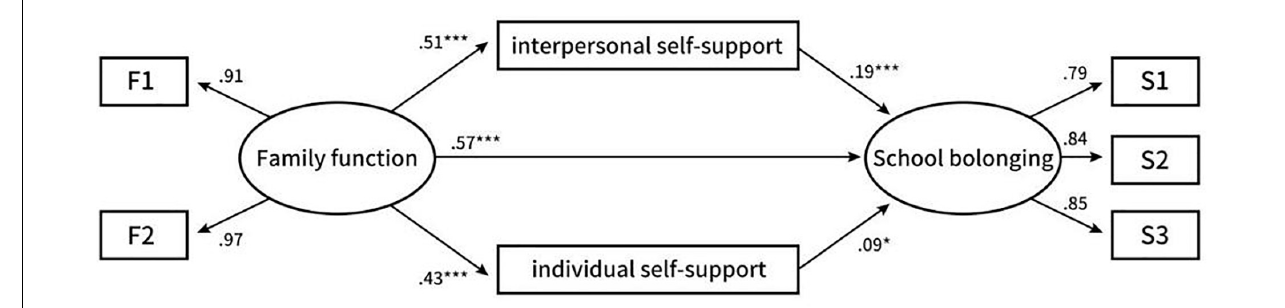
TABLE 2 | Bootstrapping indirect effects and 95% confidence intervals (CI) for the model.